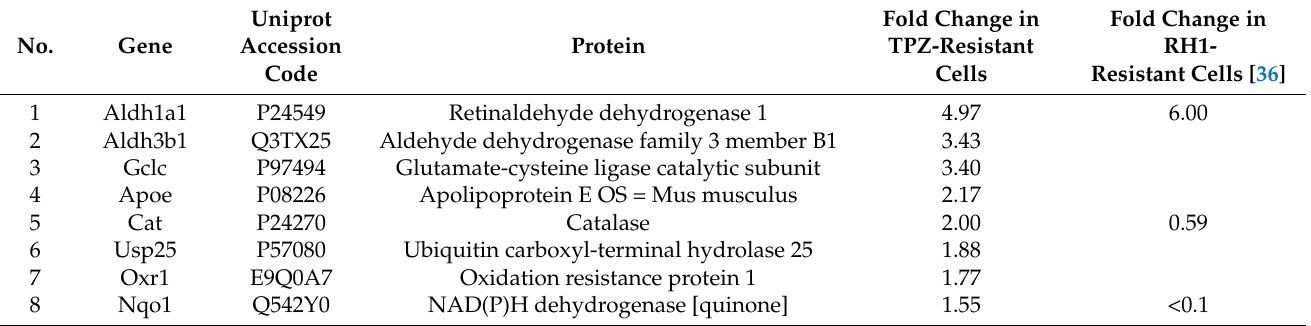
Table 2. Differently expressed oxidative stress response proteins in TPZ-resistant MH22a